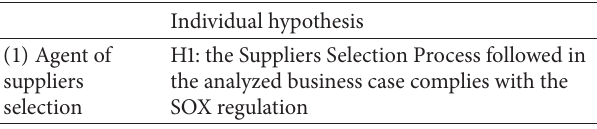
Table 14: Agent’s hypothesis.